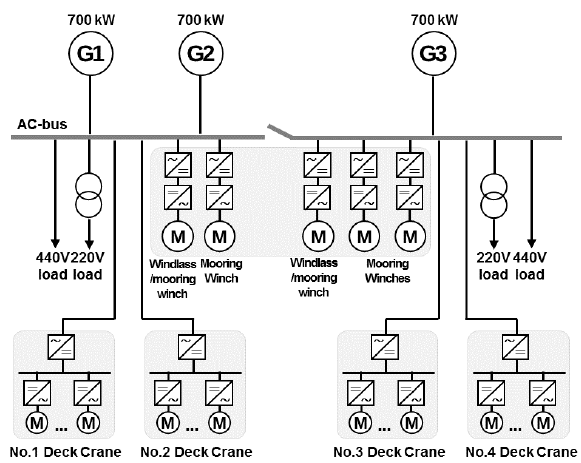
Figure 2. Layout of a conventional power system.